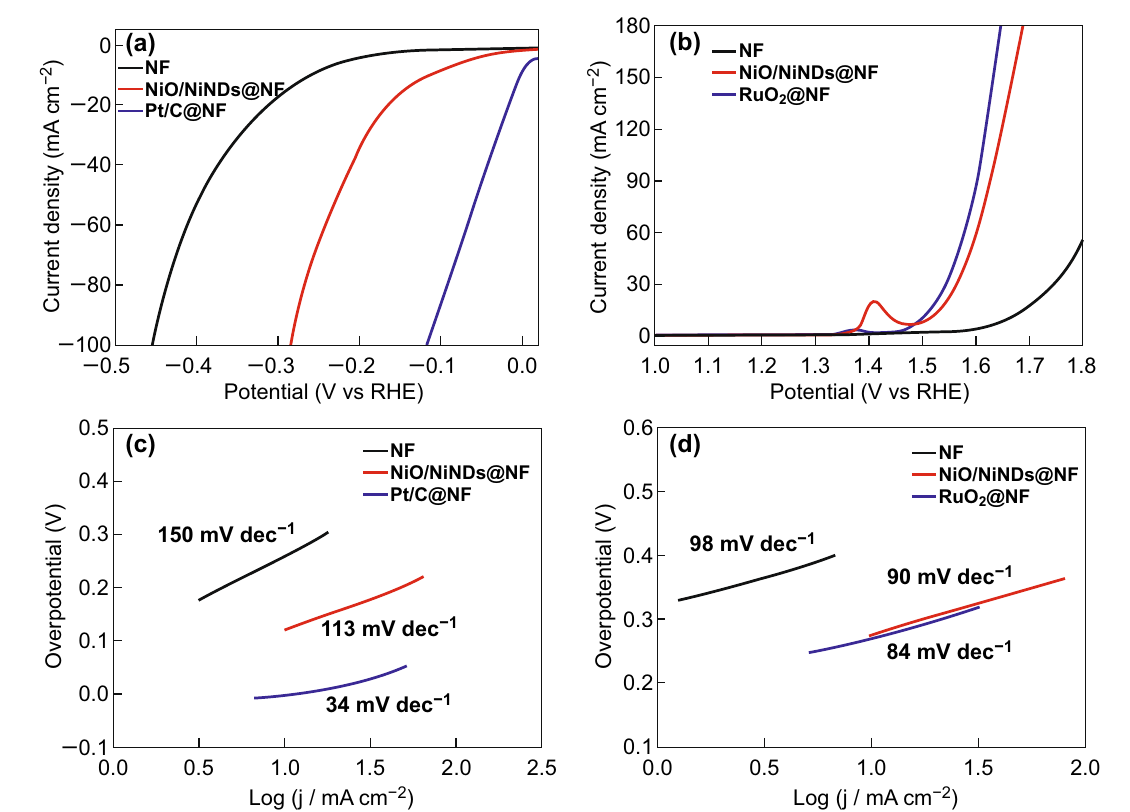
Fig. 3 a HER and b OER characteristics of different catalyst electrodes under 1 mg cm −2 loading determined using linear sweep voltammetry with a three‑electrode configuration in 1 M KOH aqueous electrolyte. All of the scan rates were 2 mV s −1 . Tafel plots of different catalyst elec‑ trodes for c HER and d